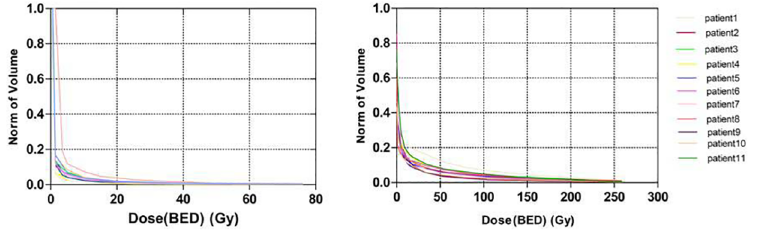
Fig 2. Dose-volume histogram of the lung for eleven patients after radiobiological conversion in SBT and SBRT plans.